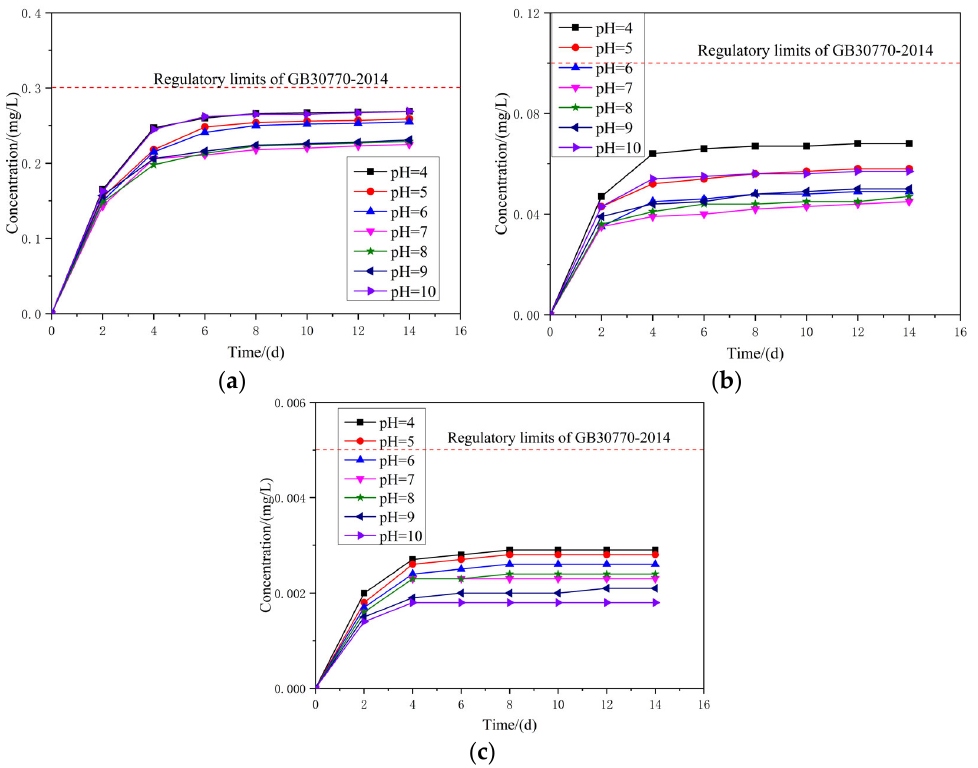
Figure 10. Leaching test result of heavy metals in ATCA concrete (unit: mg/L): ( a ) leaching of Sb; ( b ) leaching of As; ( c ) leaching of Hg.